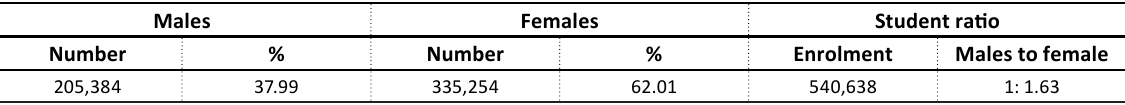
Table 7. Percentage and ratio of students at public higher education institutes by gender Source: Planning, Research and Policy Coordination Division, MOE